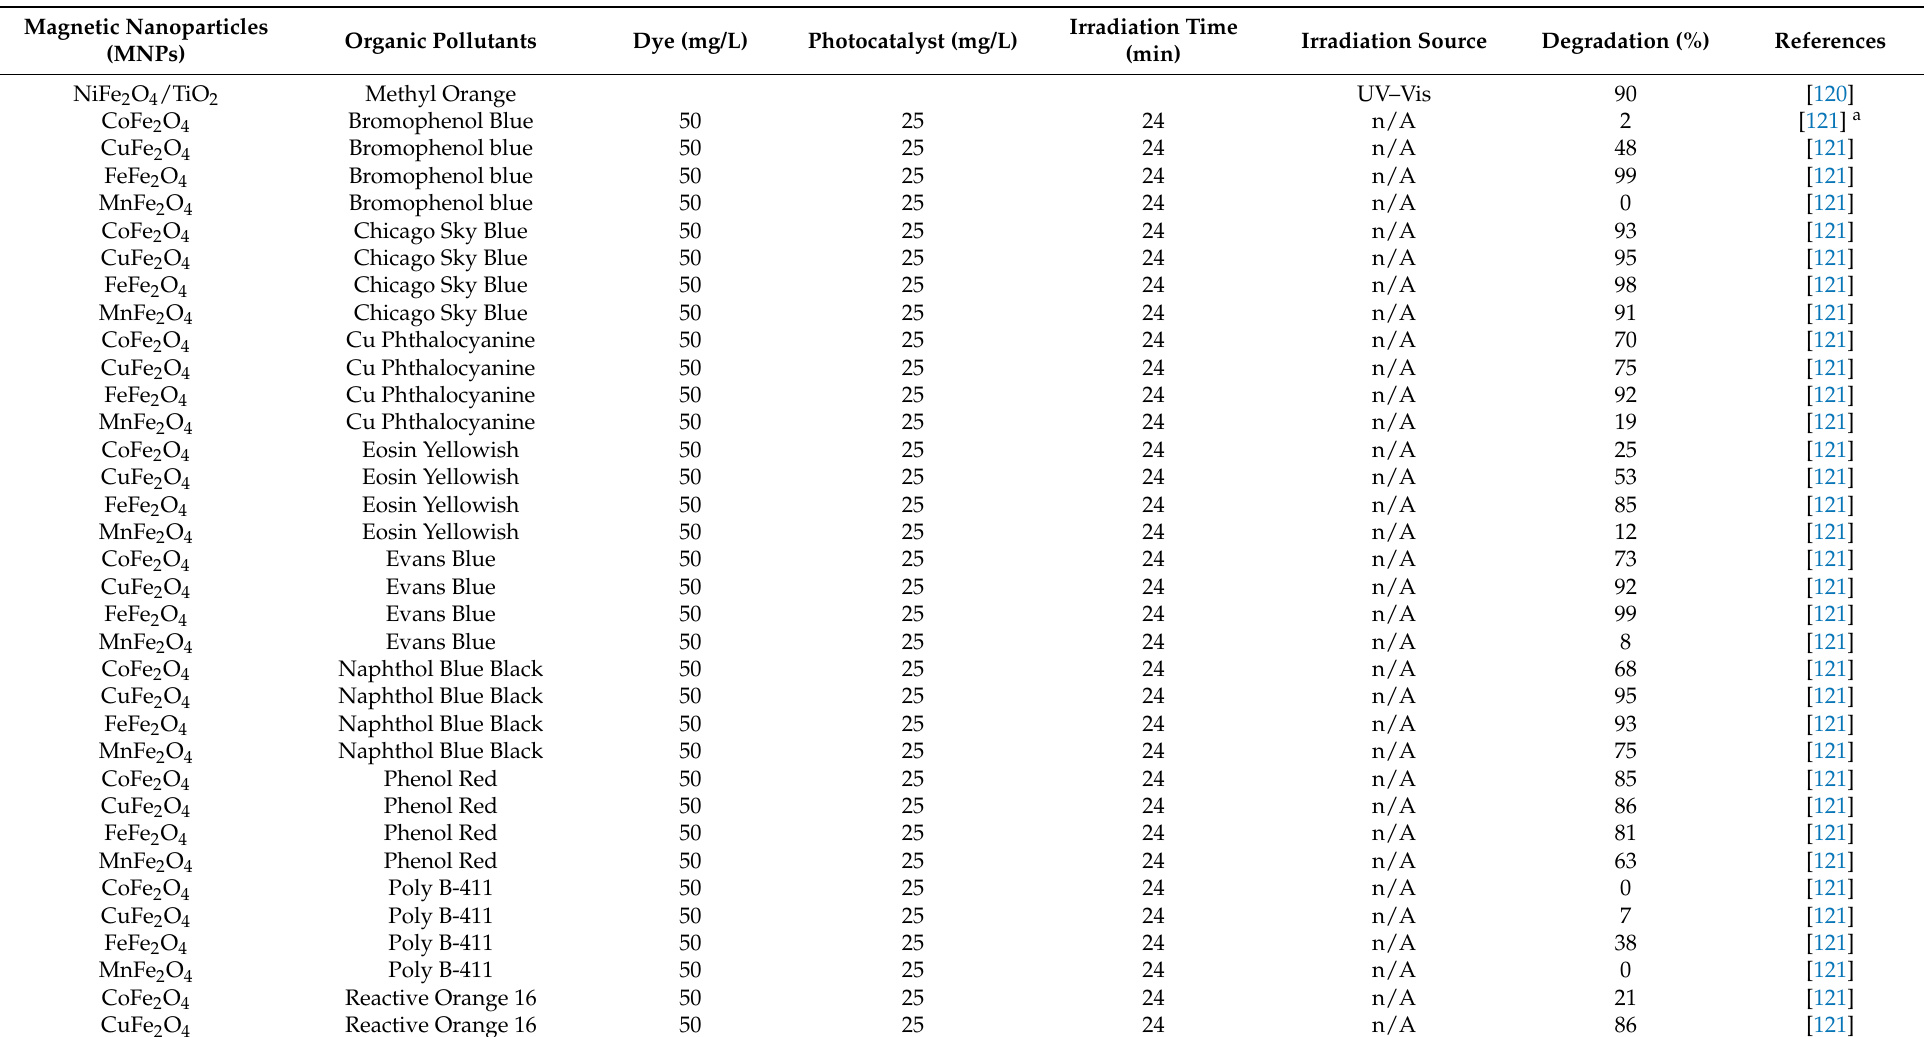
Table 2. Previous studies showing the photocatalytic degradation of organic pollutants using magnetic ferrites and ferrites-based zinc oxide and titanium oxides nanocomposites. Magnetic